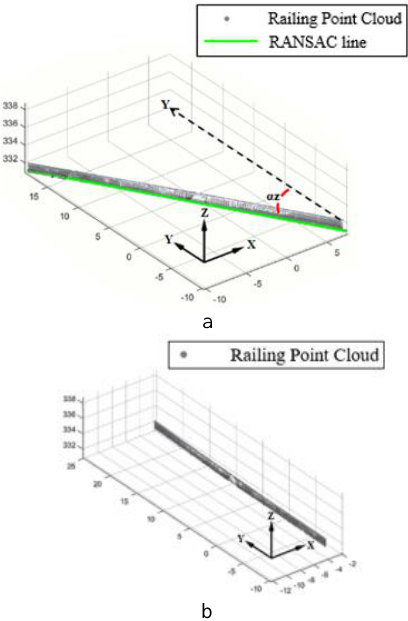
Figure 2. a: RANSAC line fitting and the angle between the fitted line and the Y -axis ( αz ); b: The rotation of the points around the Z -axis using corresponding total rotation angle ( αz ). Each patch is partially rotated in two directions (e.g. around the Z and X axes) at the predefined intervals in order to model the curvatures of the railing elements in the bridge. The best partial rotation angle (e.g. Δαz , Δαx ) is selected based on the maximum number of inlier points on the fitted model. Next, the 3D model of each patch is reconstructed by adding the Y values to the coordinates of the 2D model’s vertexes and then converted to the original coordinate system by inverse rotating of points around the X and Z axes (Figure